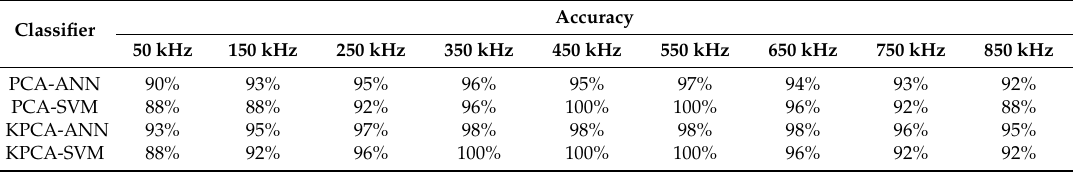
Table 3. Classification accuracy for different classifiers at different